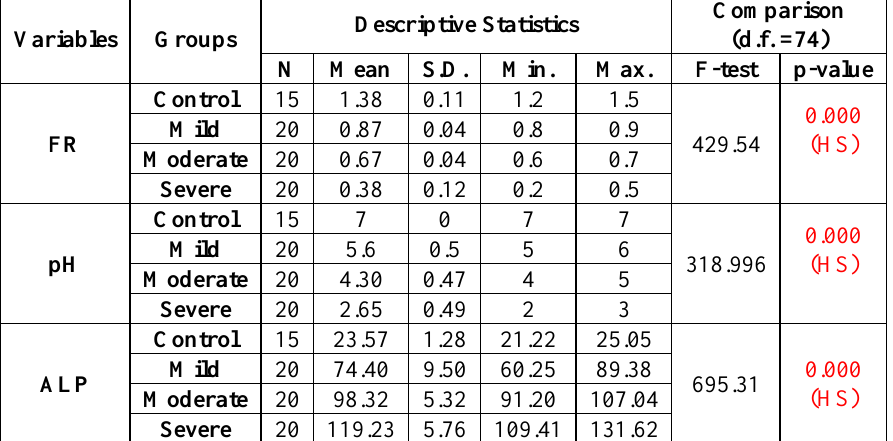
Table 2:Descriptive and inferential statistics of FR, pH and ALP parameter for control and study